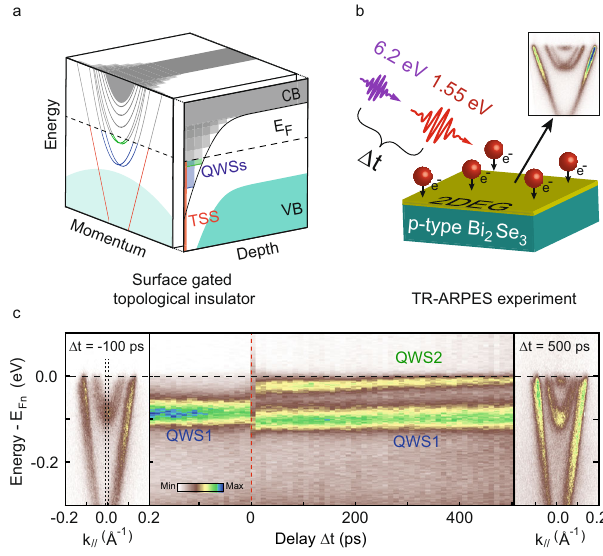
Fig. 2 TR-ARPES of surface-gated topological insulators. a Representation of the surface and bulk electronic structure in a surface- gated topological insulator as a function of momentum, energy, and distance from the surface (the side view displays the momentum integrated projection of the band structure, where CB and VB are the conduction and valence bands). Two-dimensional electron gases (2DEGs) taking the form of spatially con fi ned quantum well states (QWSs) are created by a suf fi ciently large positive bias applied to the surface. The dispersion, Rashba-splitting, and spatial extent of the 2DEGs depend on the detailed shape of the band bending. Here, the band bending pushes the two lowest QWSs (blue and green) below the Fermi energy. b TR-ARPES experiment on p-type Bi 2 Se 3 ; the cleaved sample is gated in situ by alkali atom deposition. A near-infrared (1.55 eV) “ pump ” pulse perturbs the system, and a UV (6.2 eV) pulse is used to probe the electronic structure by ARPES. The time delay ( Δ t ) between pump and probe pulses is varied to resolve the electron dynamics. c Temporal evolution of the QWSs in p-doped Bi 2 Se 3 plotted relative to the electron quasi-Fermi level E Fn . The left panel shows the ARPES spectra of all surface states before pump arrival ( – 100 ps); in the center panel photoemission intensity integrated around the Brillouin zone center (black dashed lines) is shown as a function of time (pump and probe are overlapped at time zero, red dashed line). We observe that a second QWS emerges after the pump excitation; the right panel shows the dispersion at 500 ps, characterized by two partially populated